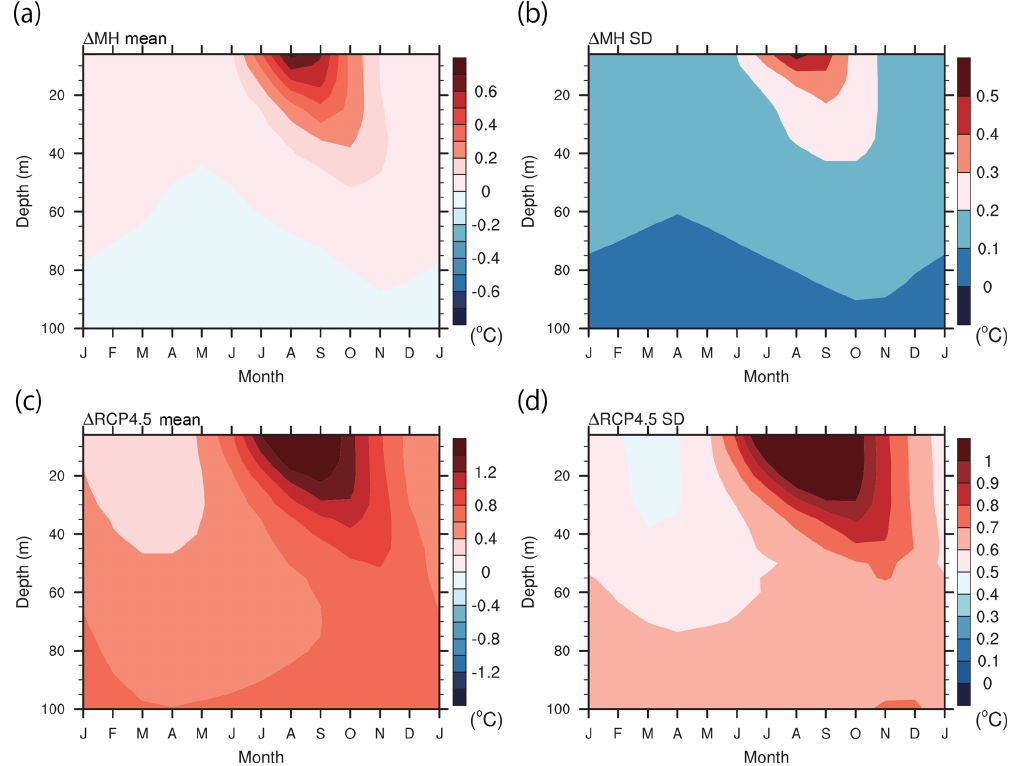
Figure 10. Same as in Fig. 6 but for the upper ocean temperature change ( ◦ C) (north of 60 ◦ N). The nine models except for FGOALS-g2 listed in Table 2 are